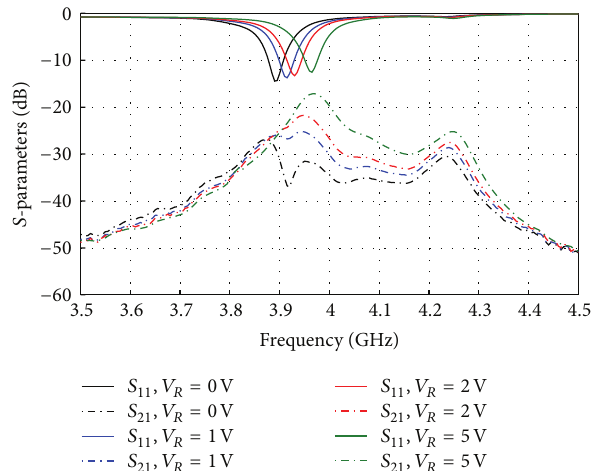
Figure 16: Measured 𝑆 -parameters of the proposed pattern diversity tunable filter-antenna.